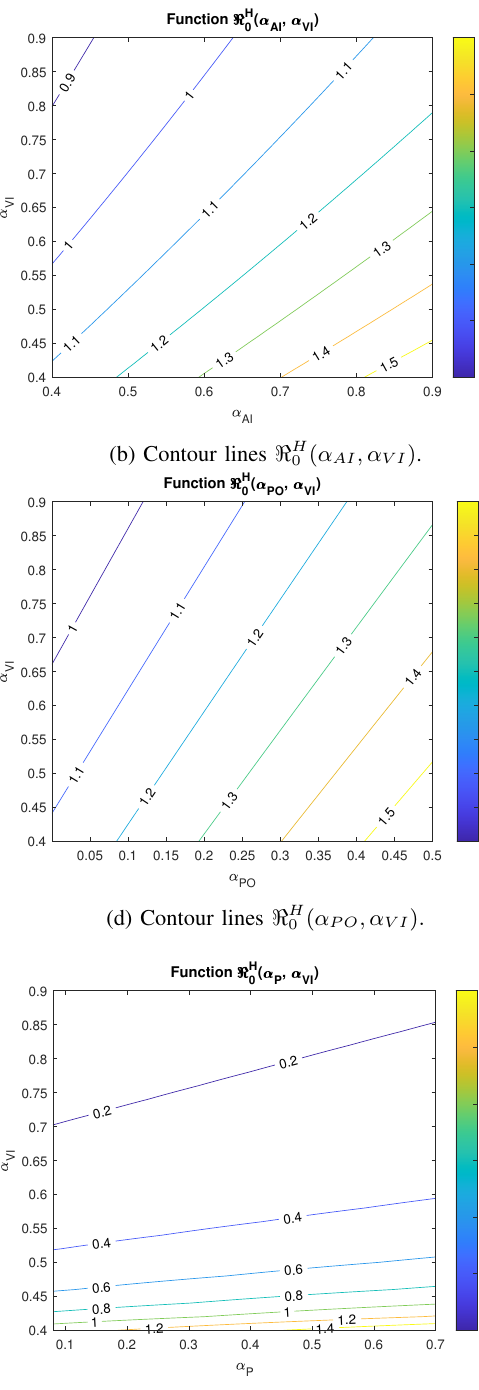
(a) Behavior of (cid:60) H 0 for α AI , α V I ∈ [0 . 4 , 0 . 9] . (b) Contour lines (cid:60) H 0 ( α AI , α V I ) .